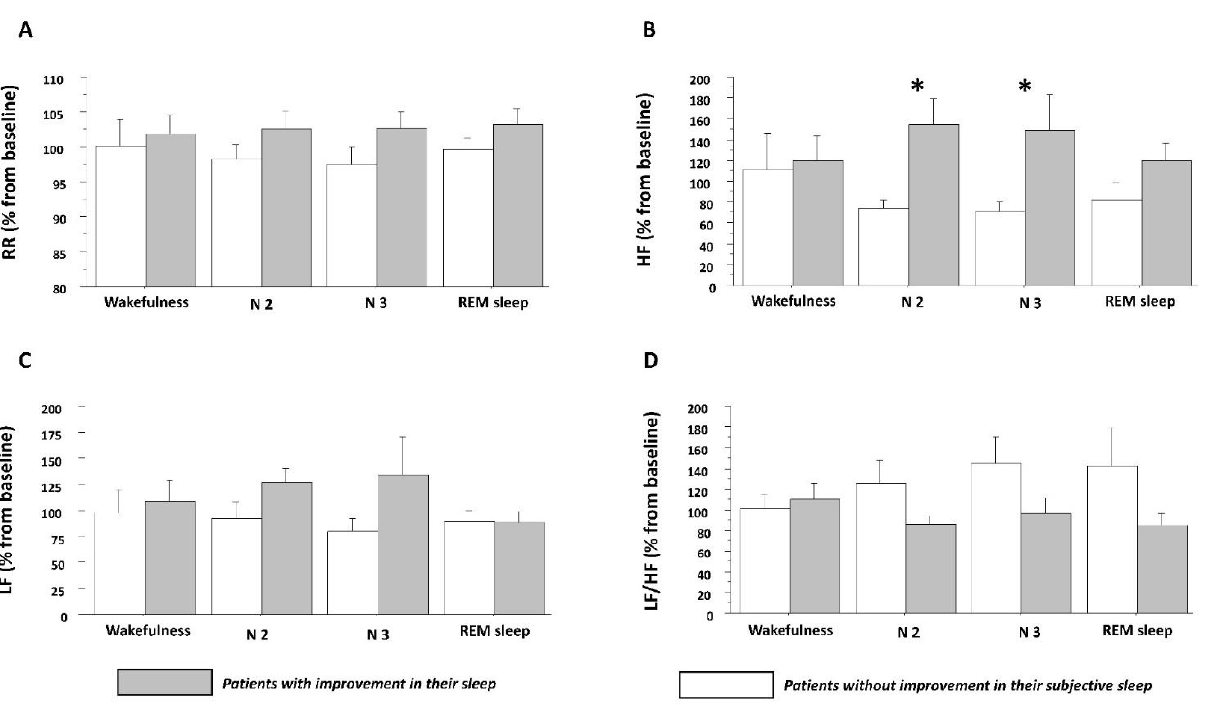
Figure 1. Heart rate variability according to states of vigilance and sleep improvement following CBT. Abbreviations: Cognitive-behavioral therapy (CBT); High-frequency power (HF); Low-frequency power (LF); Ratio of low to high frequency (LF/HF); Stage N2 (N2); Stage N3 (N3); Rapid-eye-movement sleep (REM); RR intervals (RR).